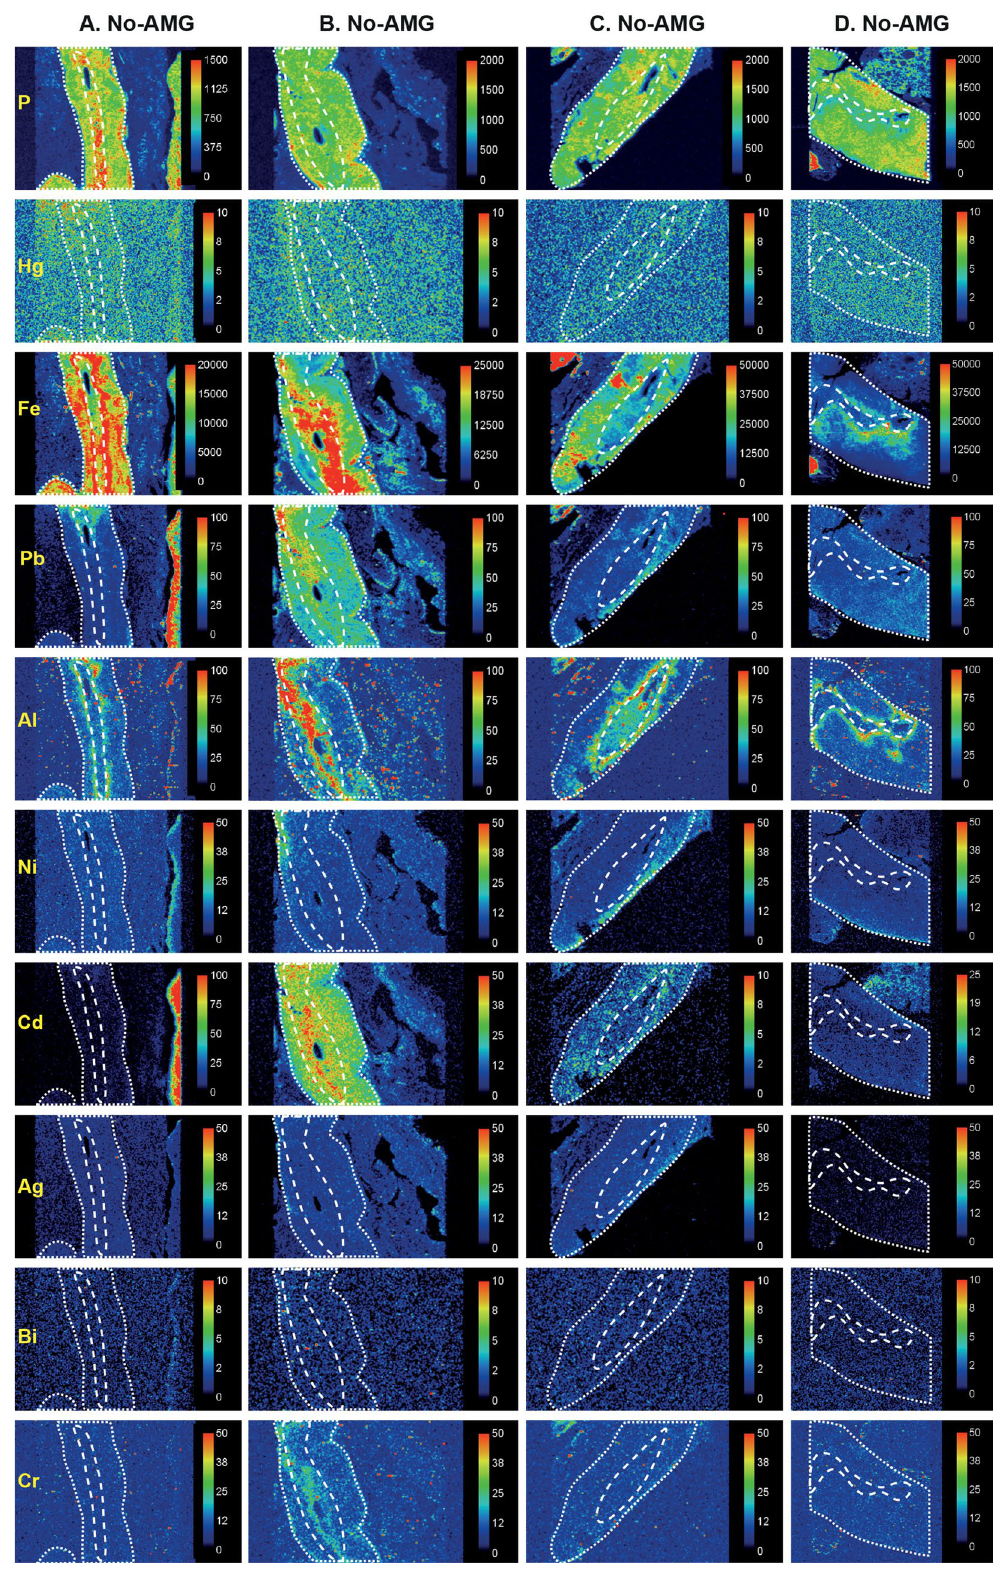
Figure 8. LA-ICP-MS III. The dotted lines outline the adrenal gland in the section, the medulla is outlined by the internal dashed lines, and the cortex occupies the space between the dashed and dotted lines. Phosphorus LA-ICP-MS indicates the degree of cellularity. No mercury is seen in adrenal glands that did not stain with AMG ( A – D ). Metals in both cortex and medulla are iron ( A – C ), cadmium ( B ), lead ( B ), and aluminium (in the zona reticularis, C ). Metals present selectively in the medulla are aluminium ( B ) and chromium ( B ). Aluminium is seen mostly in the zona reticularis of the cortex in ( A , D ). Cadmium is present mostly in the cortex in ( C ), and iron in the inner cortex in ( D ). In ( D ), thyroid tissue (containing cadmium) is present at the upper right and lymph node tissue (containing iron) at the lower left. Scale = counts per second (proportional to